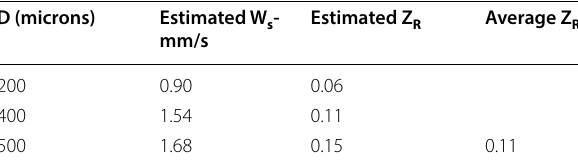
Table 3 Estimated values of Ws by Eq. 5 and corresponding values of Z for the Grijalva R